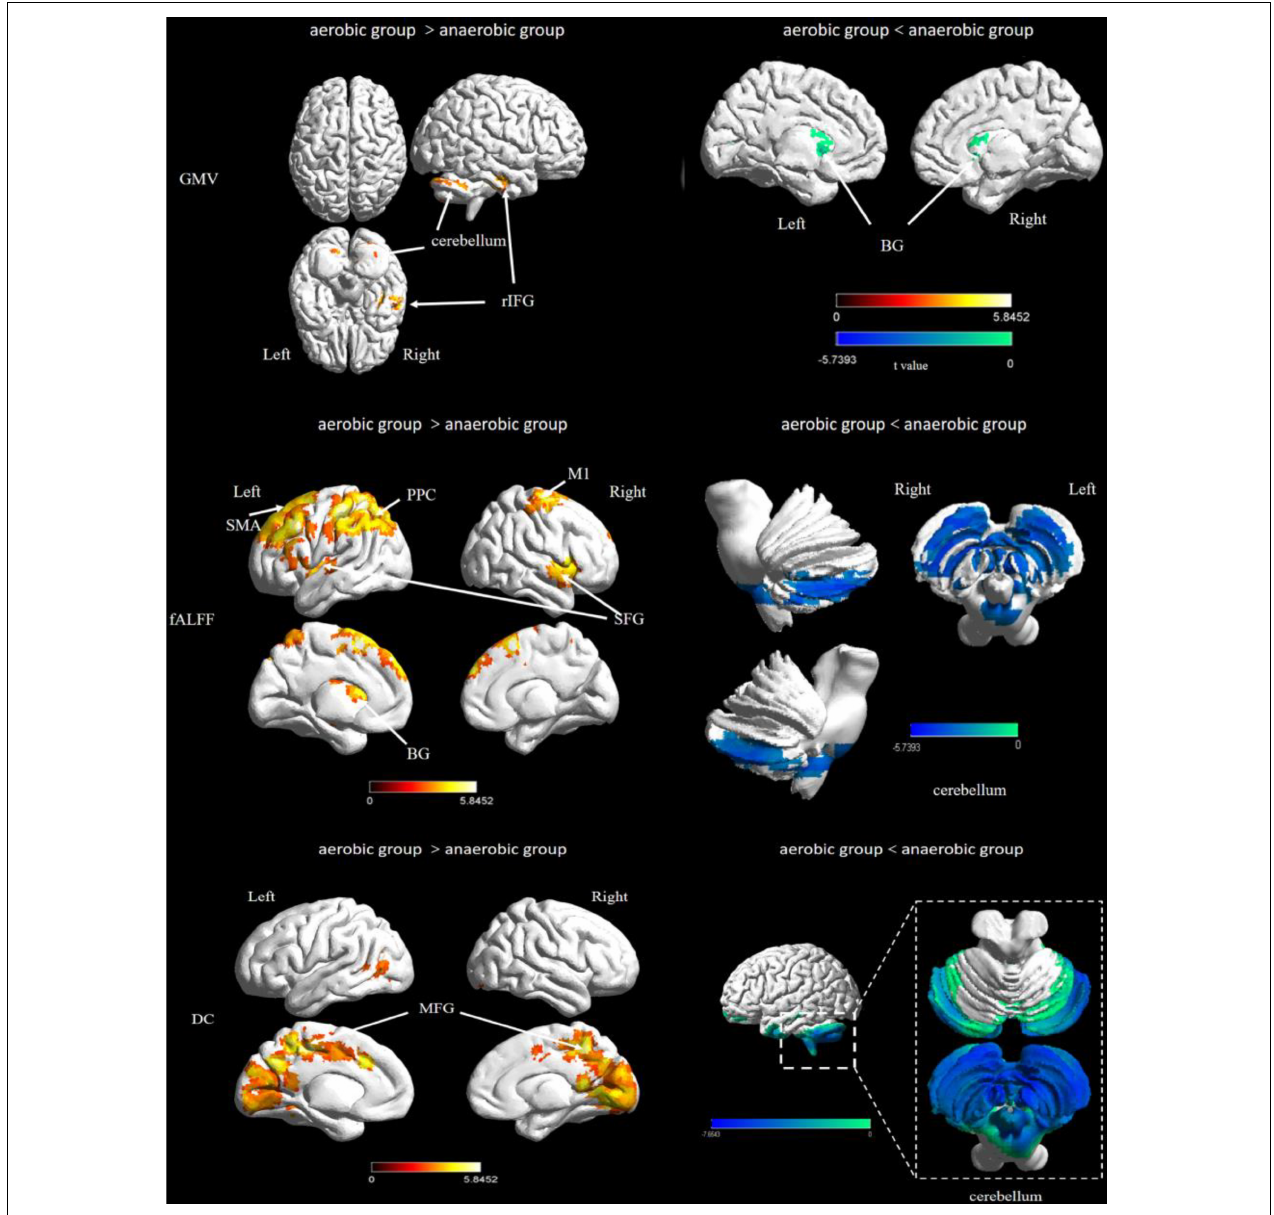
FIGURE 1 | Difference of brain structural and functional plasticity characteristics between elite endurance and sprint athletes. ITG, inferior temporal gyrus; BG, basal ganglia; SFG, superior frontal gyrus; PFC, prefrontal lobe cortex; PPC, posterior parietal cortex; MFG, Middle Frontal Gyrus; OTC, occipitotemporal